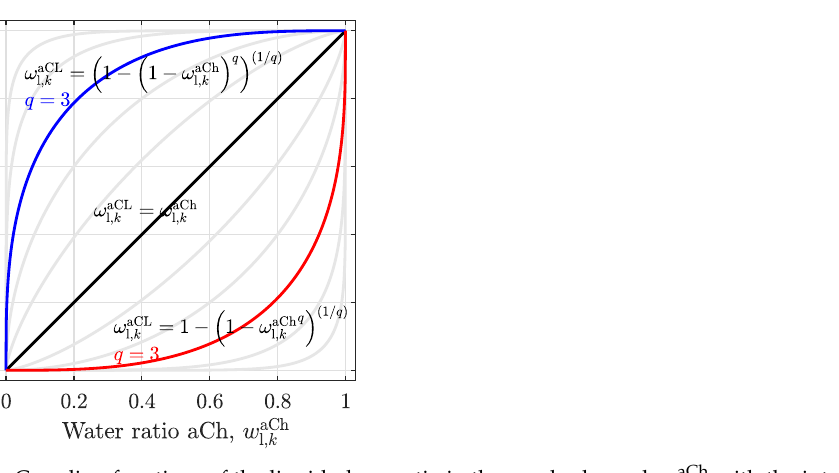
with the interfacial l, k l,